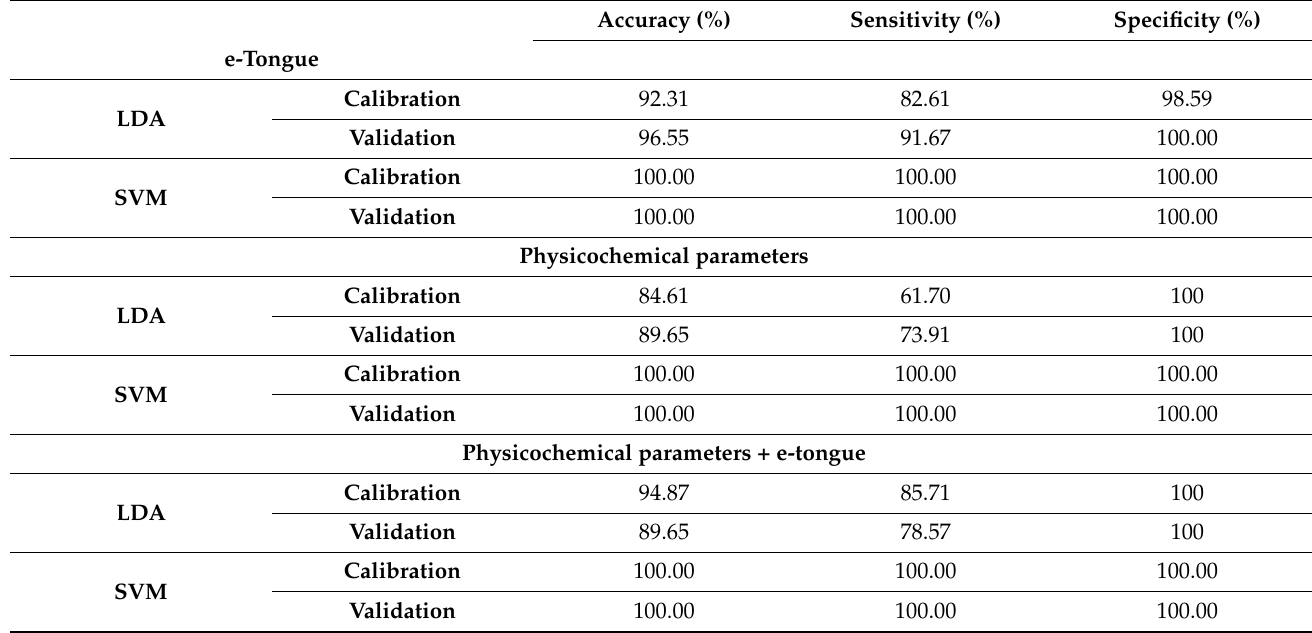
Table 2. Statistical parameters of the LDA and SVM discrimination of authentic and adulterated